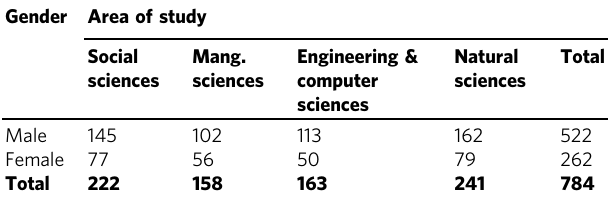
Table 2 Distribution of sampled respondents by